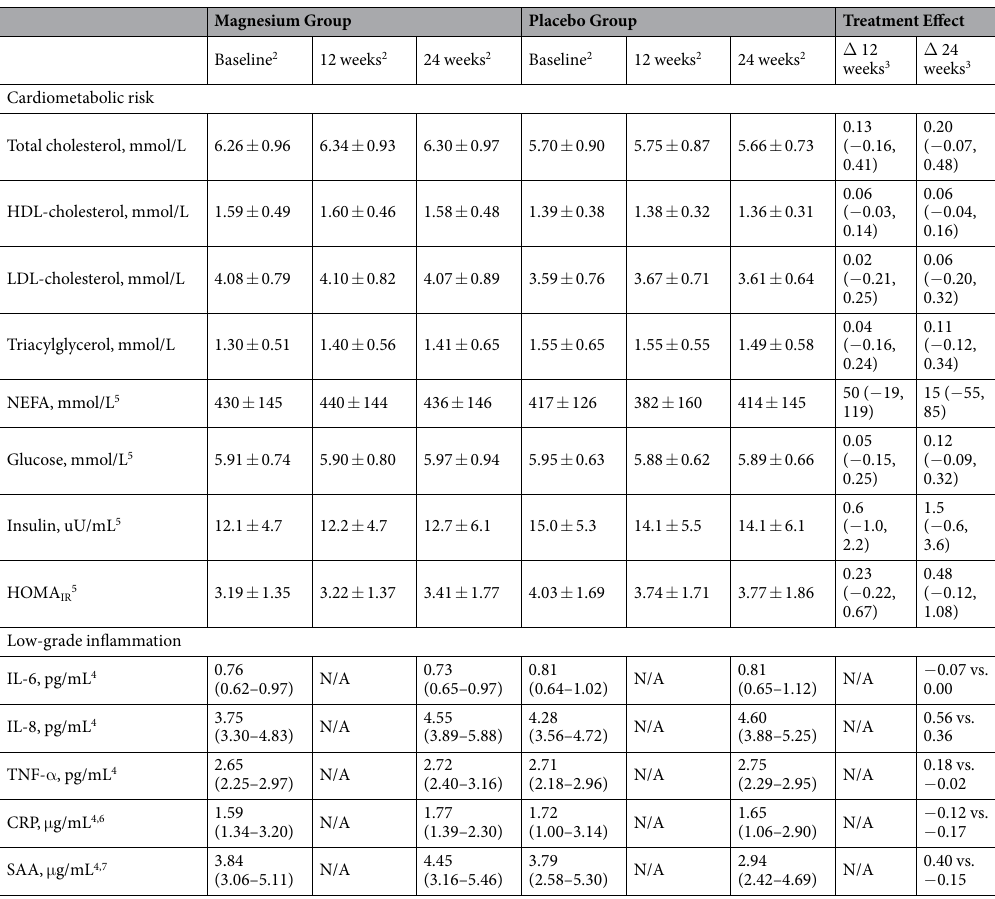
Table 2. Cardiometabolic risk measurements at baseline, and after a 12-week and 24-week magnesium or placebo treatment in a randomized controlled trial (RCT) with overweight and obese middle-aged and elderly adults 1 . 1 Magnesium group: n = 26; placebo group: n = 25. NEFA: non-esterified fatty acid; IL: interleukin; TNF: tumor necrosis factor; CRP: C-reactive protein; SAA: serum amyloid A; N/A: not available. 2 Values are means ± SDs or medians (25–75 th percentile). 3 For normally distributed variables, values are mean changes (95% CI) obtained from a one-way ANCOVA with baseline value as covariate. For non-normally distributed variables, variables are the median of the changes in respectively the magnesium and the placebo